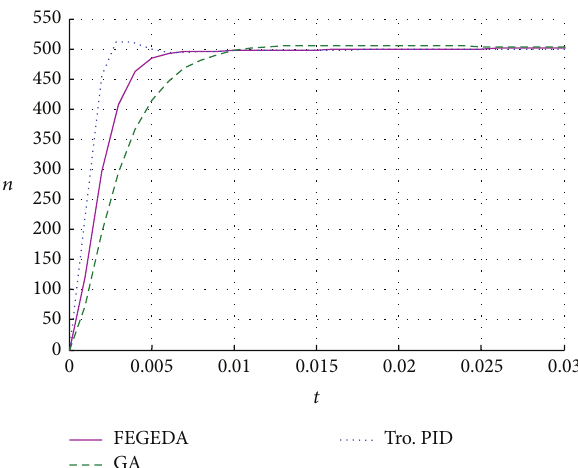
Figure 13: The system response of PMSM with different